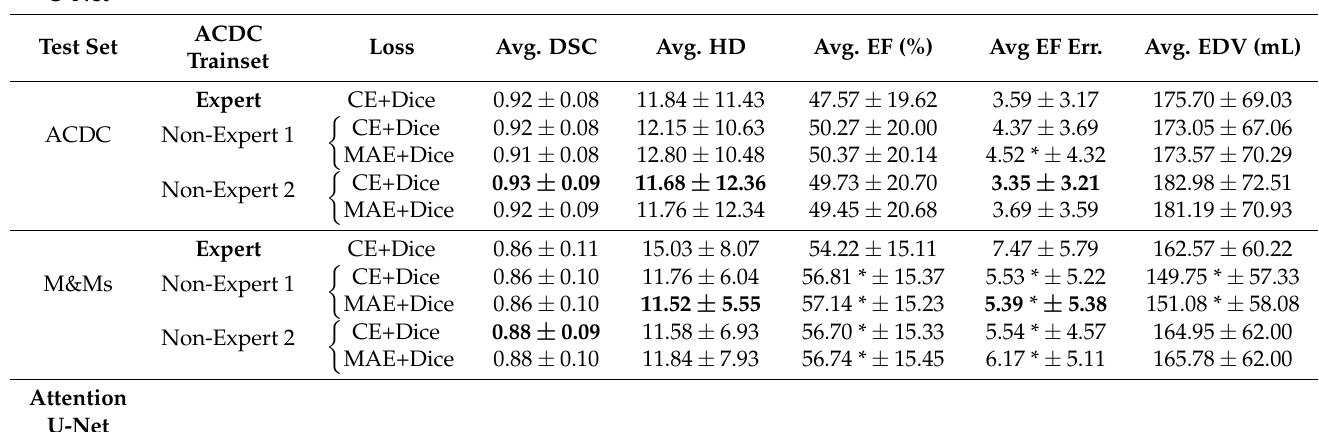
Table 1. Dice score (DSC), Hausdorff distance (HD), average ejection fraction (EF) error, and end diastolic volume (EDV) of left ventricular cavity for U-Net, Attention U-Net and E-Net with expert and non-expert annotations with data